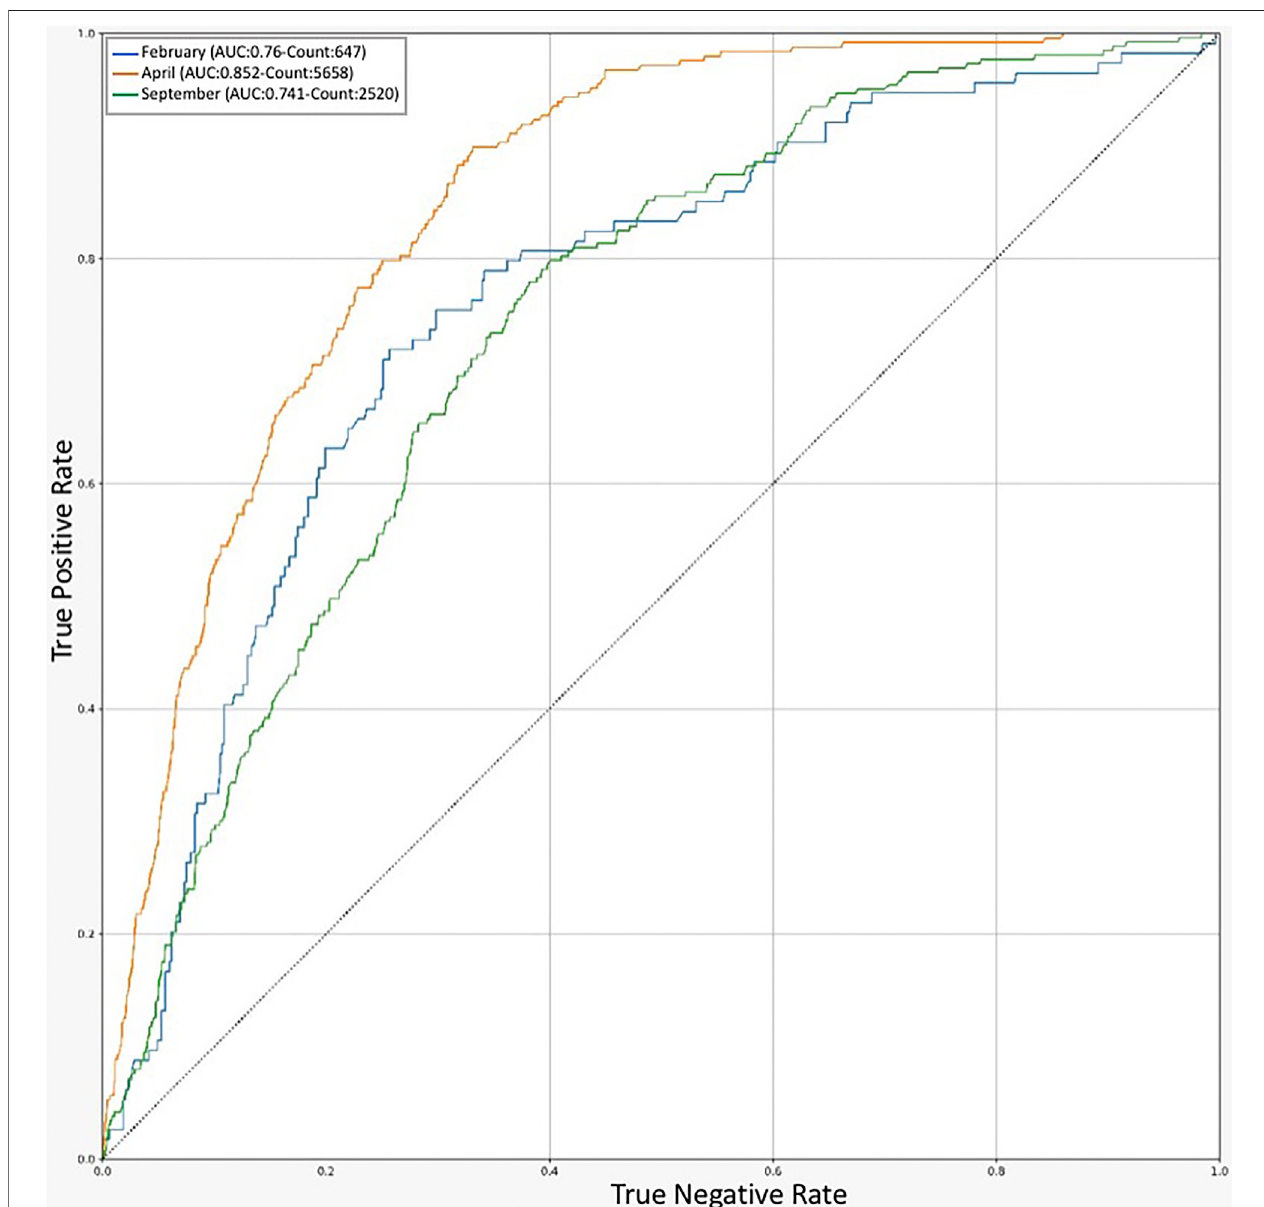
FIGURE 3 | ROC chart for Prediction of RF models in different timelines . An indicator of model performance on validation dataset in the peak months of COVID-19 outbreak in